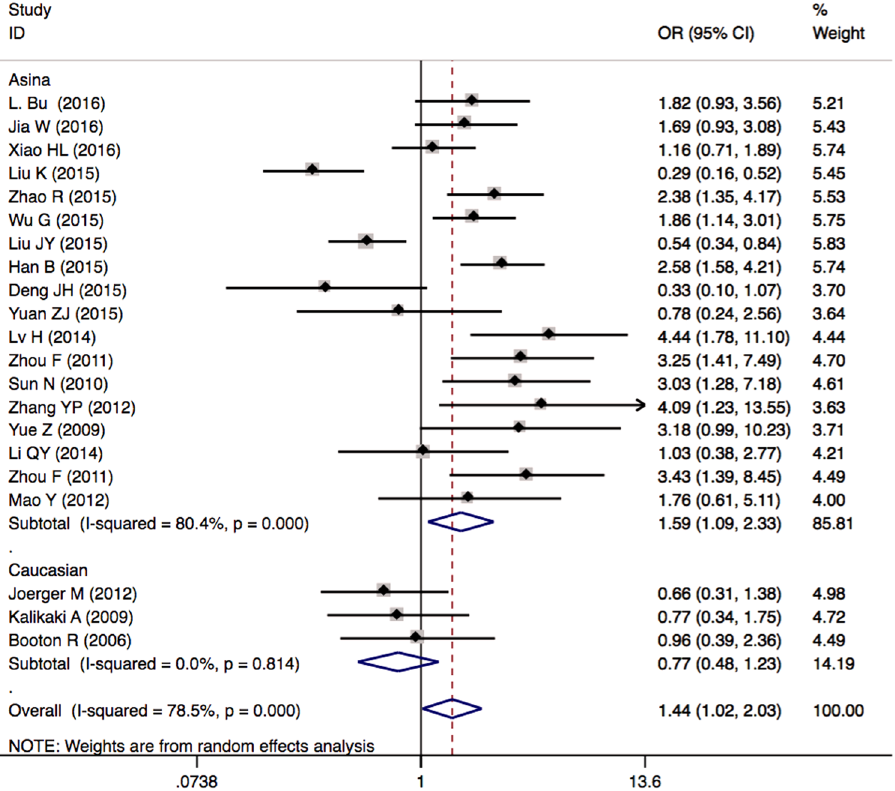
of objective response rate (ORR) stratified by ethnicity for GSTP1 IIe105Val IIe/Val + Val/Val vs .